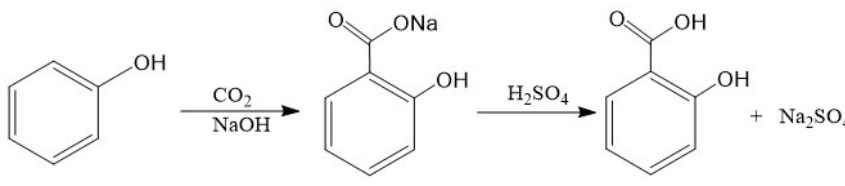
Figure 2. The Kolbe-Schmitt